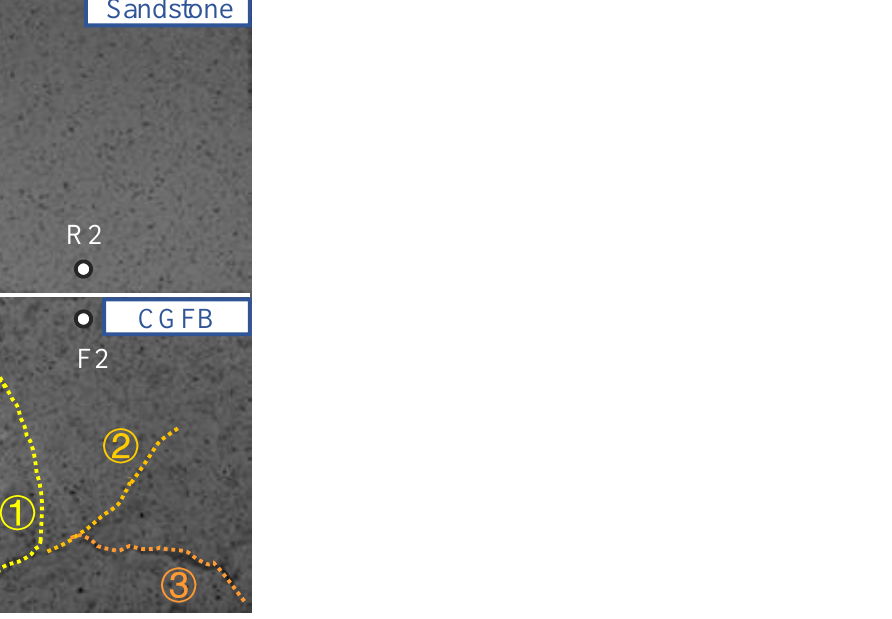
Figure 13. Monitoring points near the sandstone – CGFB intersection against macroscopic fractures.